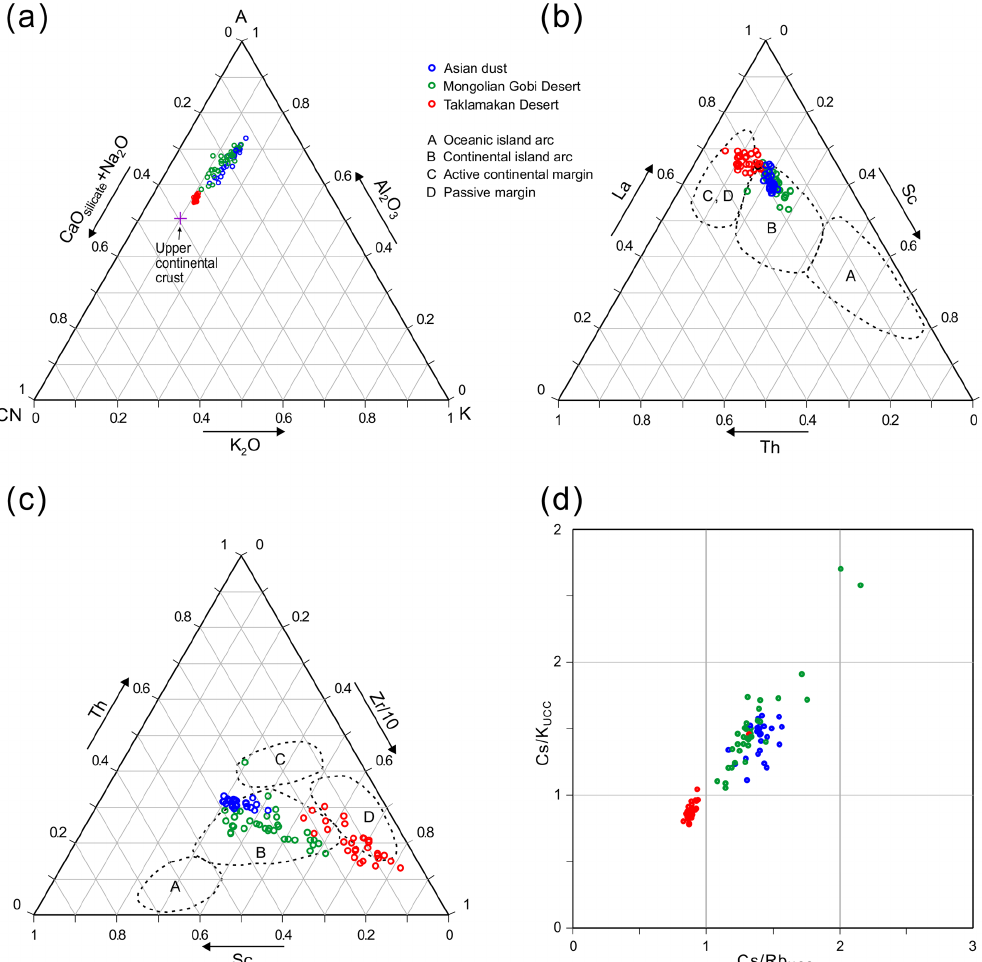
Figure 11. Plots of trace and major element compositions for discriminating the source of Asian dust. (a) A–CN–K diagram showing the molecular proportions of Al 2 O 3 , K 2 O, and CaO silicate + Na 2 O. The value of Al 2 O 3 is equivalent to the CIA. CaO silicate was obtained by the correction of carbonate CaO (Honda and Shimizu, 1998). (b) La–Th–Sc plot. (c) Th–Sc–Zr/10 plot. (d) Cs / K UCC –Cs / Rb UCC plot. Data were normalized to UCC. Data of the Asian dust and Mongolian Gobi Desert soils ( < 20µm) are from this study. Trace element data for Taklamakan Desert soils are from Jiang and Yang (2019; < 63µm). Major element data for Taklamakan Desert soils are from Honda and Shimizu (1998; < 45µm) and Jiang and Yang (2019; <